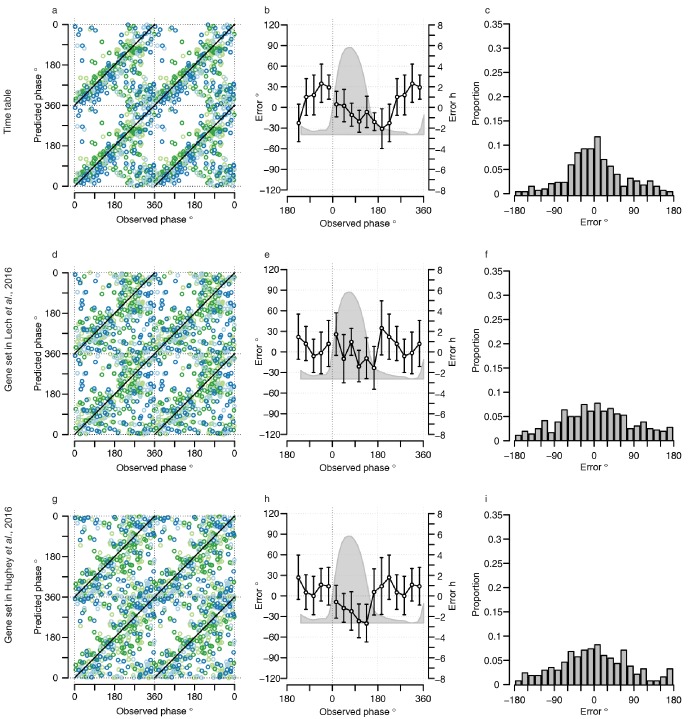
Performance of one-sample molecular timetable models when used to predict the circadian phase of samples in the validation set.Color of lines correspond to that in Figure 1 of the main text; Light blue: ‘sleep in phase with melatonin’, Dark blue: ‘sleep out of phase with melatonin’, Light green: ‘total sleep deprivation, no prior sleep debt’, and Dark green: ‘total sleep deprivation, prior sleep debt’. Panels (a, d and g) predicted circadian phase vs. experimentally observed circadian phase for each sample in the validation set for our one-sample molecular timetable model (a), molecular timetable constructed from the genes published in Lech et al. (2016) (d), molecular timetable constructed from the genes published in Hughey et al. (2016) (g). Data are double plotted. (b, e and h) Average (mean) error and 95% confidence intervals of the mean error per 30o, that is, 120 min, for each 30°Circadian phase bins across the circadian cycle, for each of the models. The grey area plot represents the average melatonin profile. (c, f and i) Frequency distribution of errors. Errors were sorted into 15o, that is, 60 min bins, for each model. For each of the models, the mode of the distribution is near 0 but the width of the distribution varies across models.